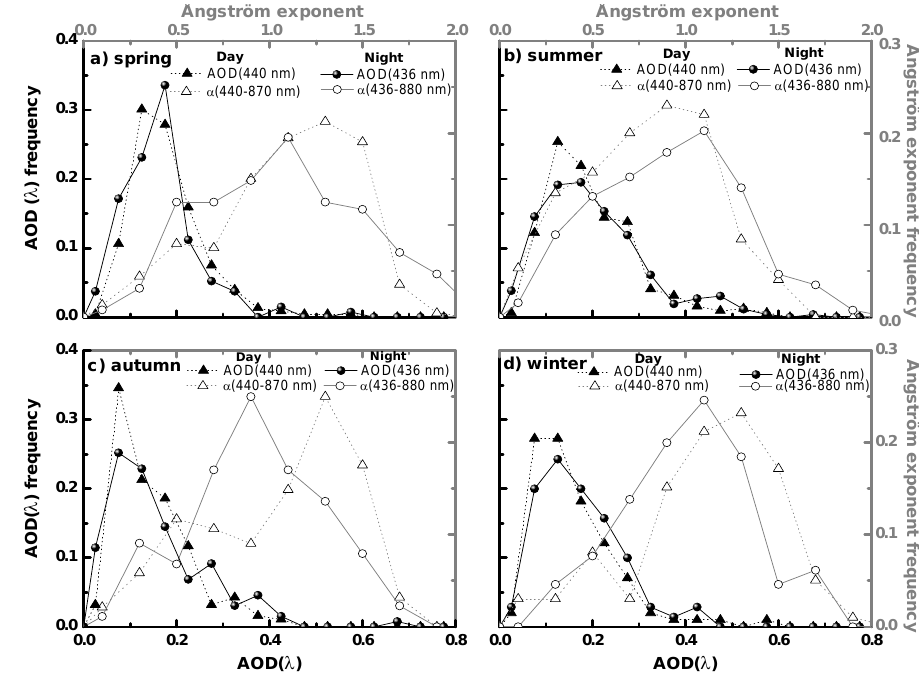
Fig. 6. Frequency histograms of AOD(440nm) and α (440–870nm) obtained at daytime and of AOD(436nm) and α (436–880nm) obtained at nighttime for: (a) spring (b) summer (c) autumn (d) winter. Table 3. Seasonal mean values and standard deviations of AOD( λ) and Angstr¨om exponent α , obtained at daytime and nighttime at Granada. Mean values and standard deviations Parameter Spring Summer Autumn Winter AOD(440nm)